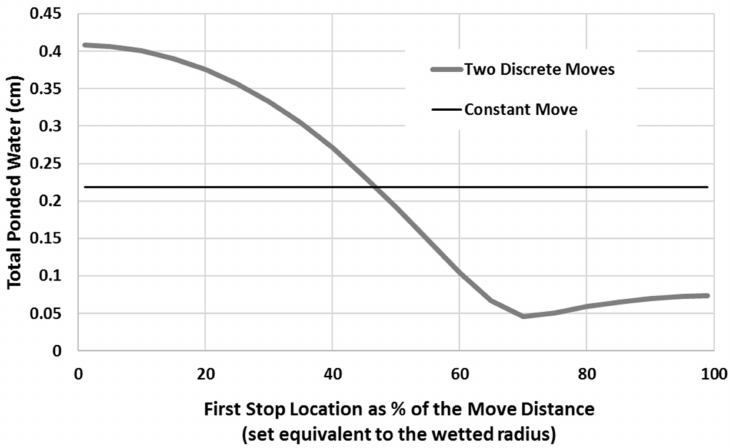
Figure 12. Calculated ponding depths at different percent of the move distance if the pivot moves occur in two discrete application rates compared to a constant move application rate for an elliptical sprinkler pattern. The move distance was set equivalent to the wetted